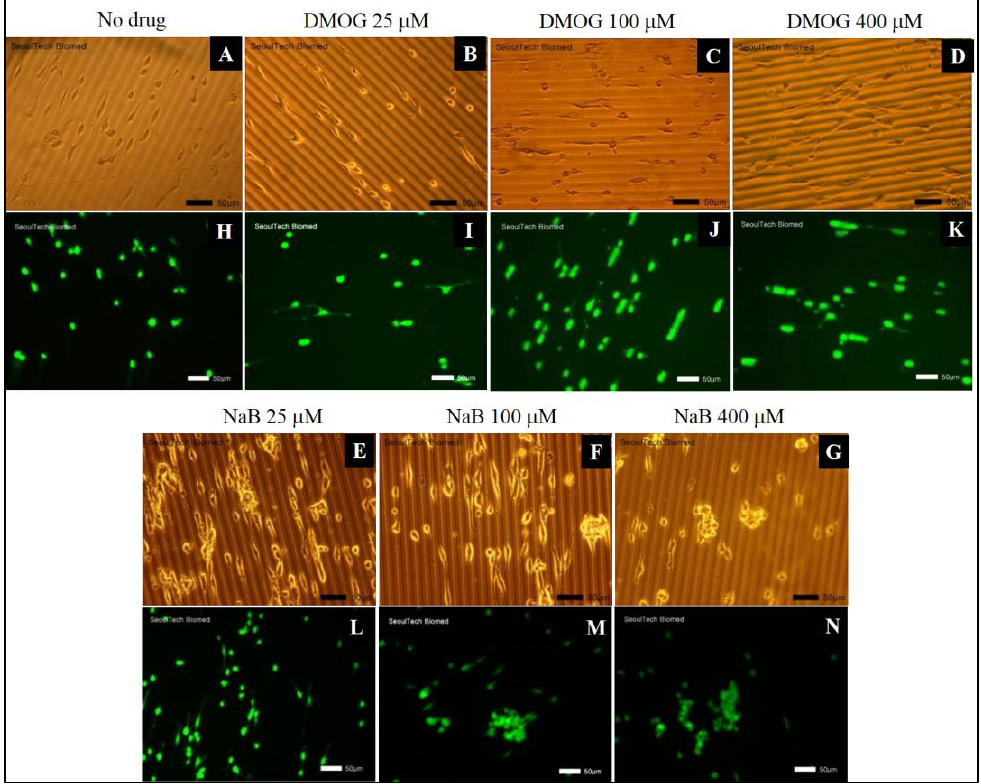
Figure 7. Cellular behavior of MC3T3 cells on the surface of HA-BDDGE patterned gel in absence or presence of DMOG and NaB in medium after 7 days: ( A , H ) No drug, ( B , I ) DMOG-25 µM, ( C , J ) DMOG-100 µM, ( D , K ) DMOG-400 µM, ( E , L ) NaB-25 µM, ( F , M ) NaB-100 µM, ( G , N ) NaB-400 µM, (scale bar = 50 µm).